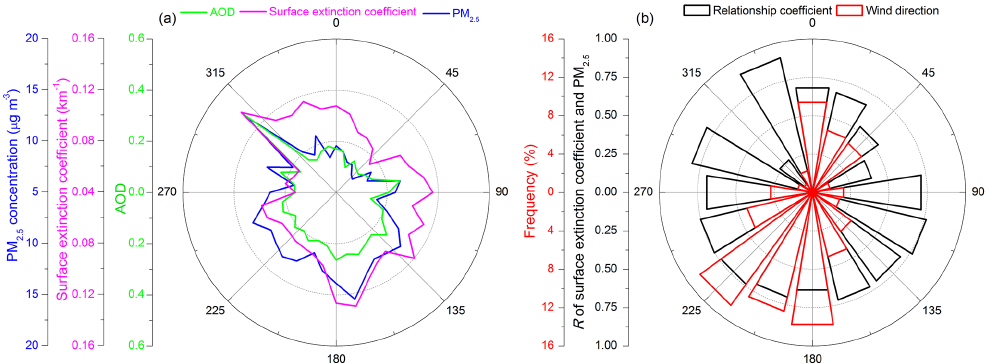
Figure 7. Wind roses of AOD (a) , surface aerosol extinction coefficient and PM 2 . 5 as a function of wind direction. (b) shows the frequency and the dependence of regression coefficient between surface extinction coefficient and PM 2 . 5 on wind